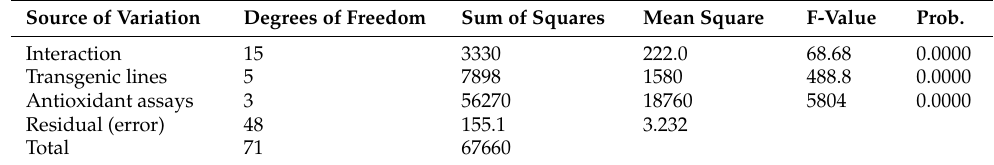
Table 3. Two-way ANOVA for antioxidant assays.